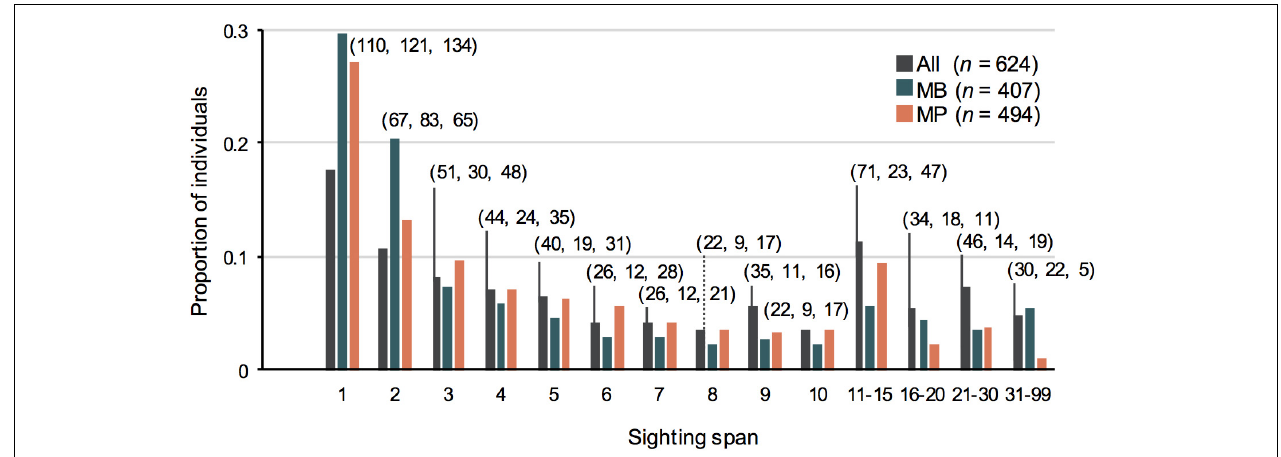
FIGURE 4 | The proportion of manta rays identified in the Nusa Penida MPA (All), and study sites Manta Bay (MB) and Manta Point (MP) plotted against the number of times individuals were sighted between January 2012 and April 2018. Total number of individuals for All, MB, MP, are shown for each number of sightings.